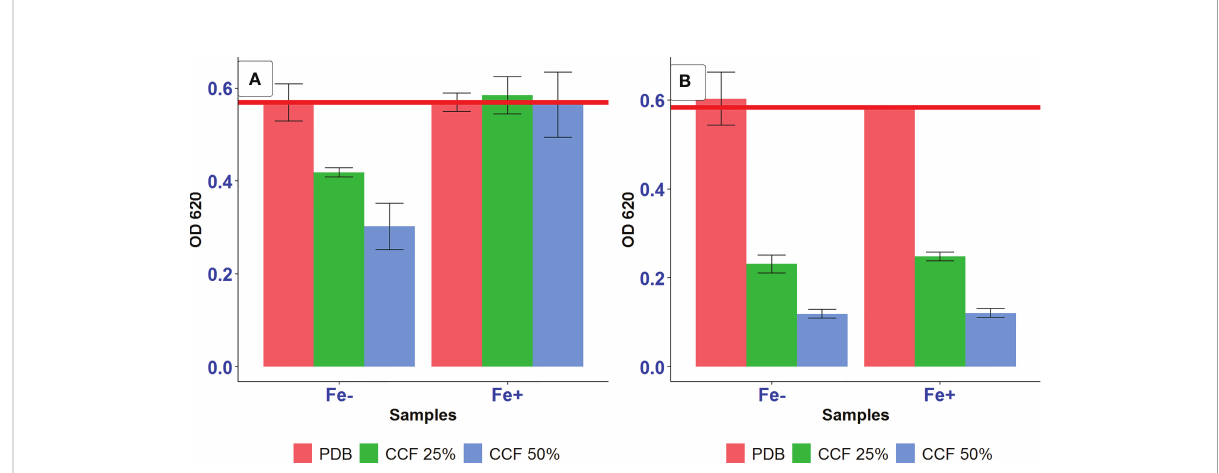
FIGURE 4 The effect of 25 and 50% CCF of P. resinovorans SZMC 25872 obtained from LMM amended with succinic acid (A) and L-alanine (B) on the growth of A. tumefaciens SZMC 14557 in the absence (Fe-) and presence (Fe+) of extra iron source (29 mg/l FeCl 3 ·6H 2 O). PDB is positive control (no added CCF), CCF 25% and CCF 50% are the corresponding CCF concentrations. The red line represents the lowest value of the positive